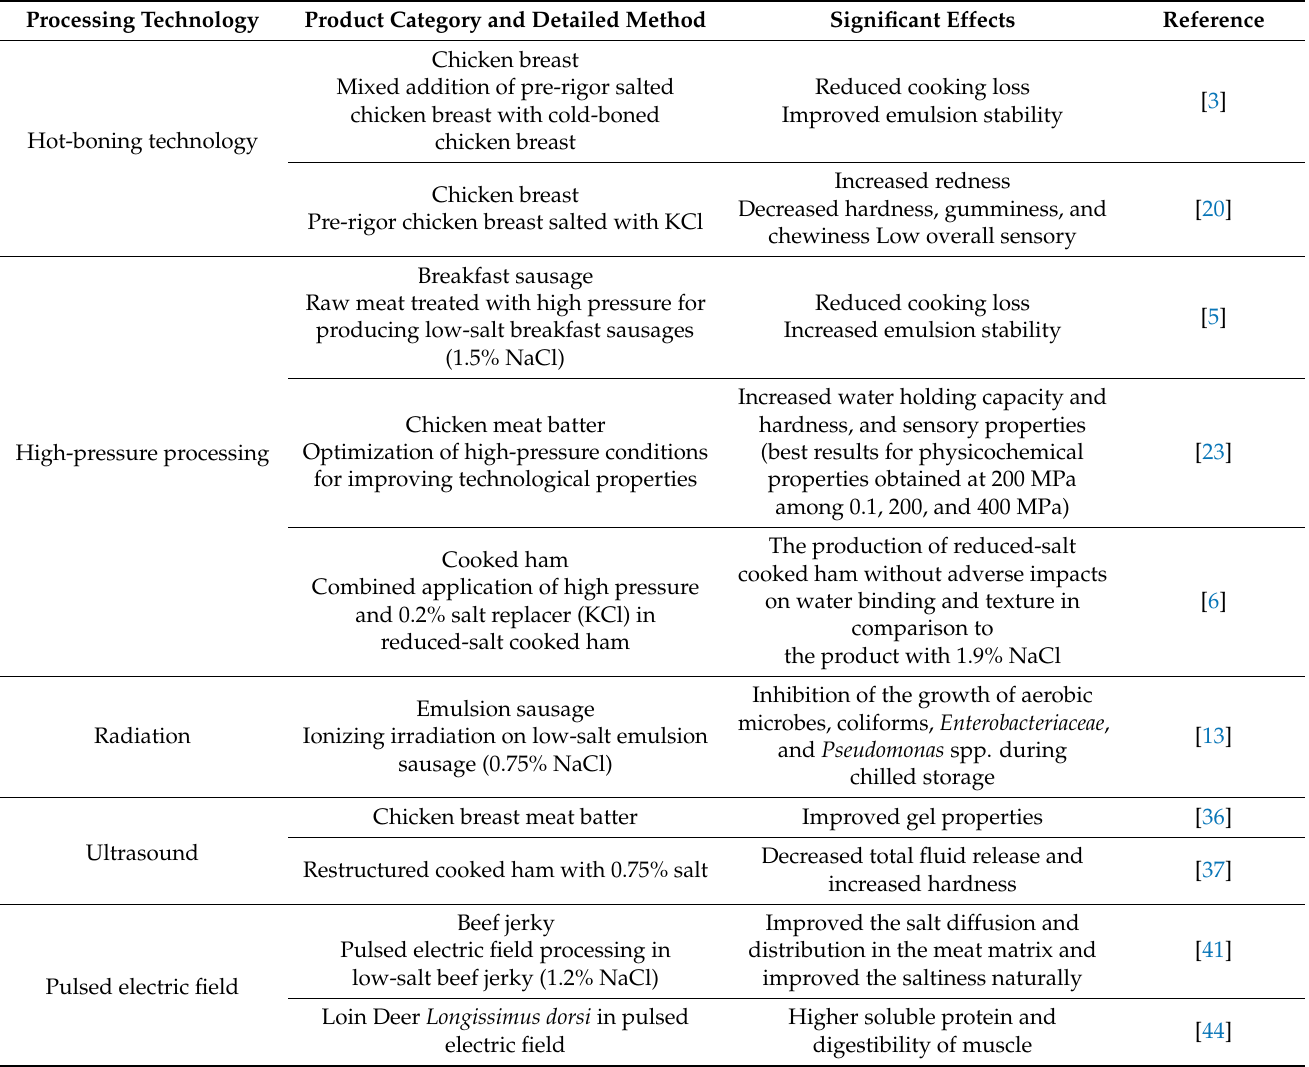
Table 1. Studies regarding the alternative processing techniques for salt reduction in meat